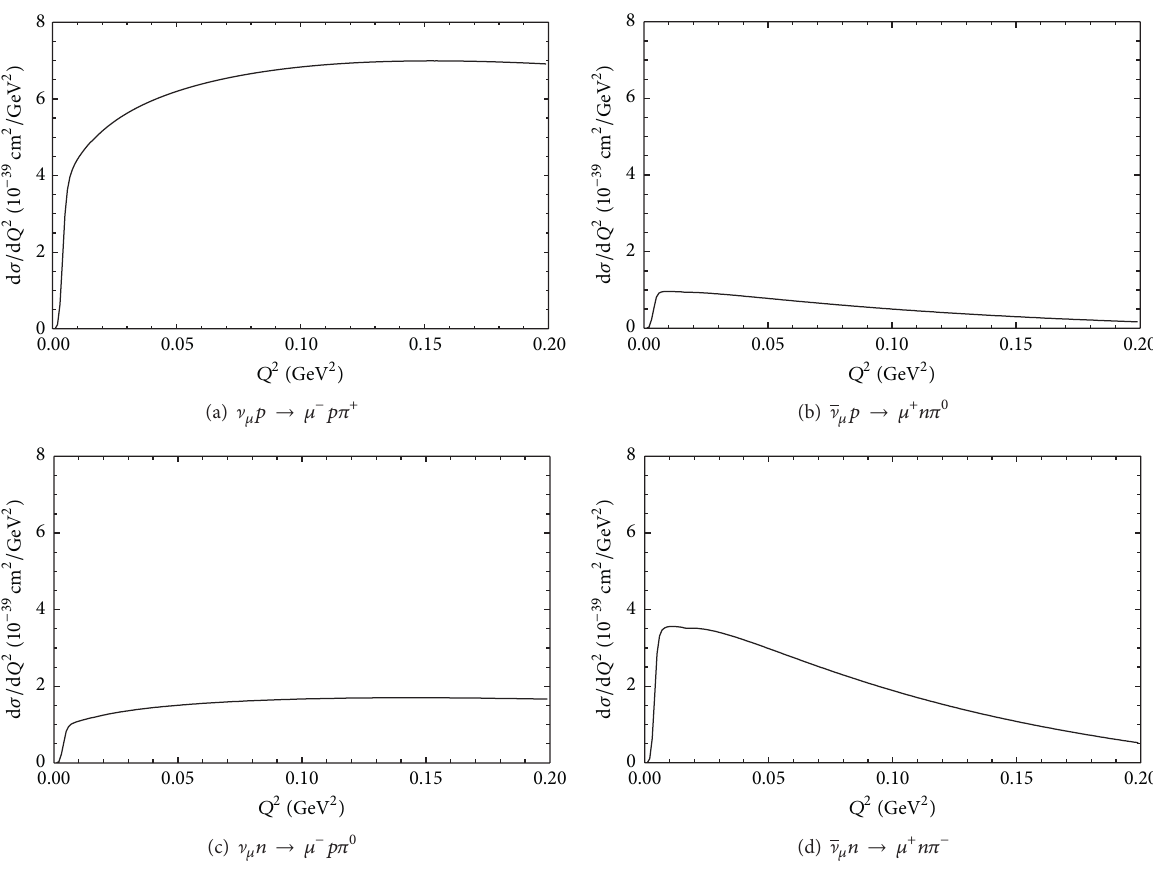
Figure 2: Charged current differential cross-sections for 𝐸 ] = 1